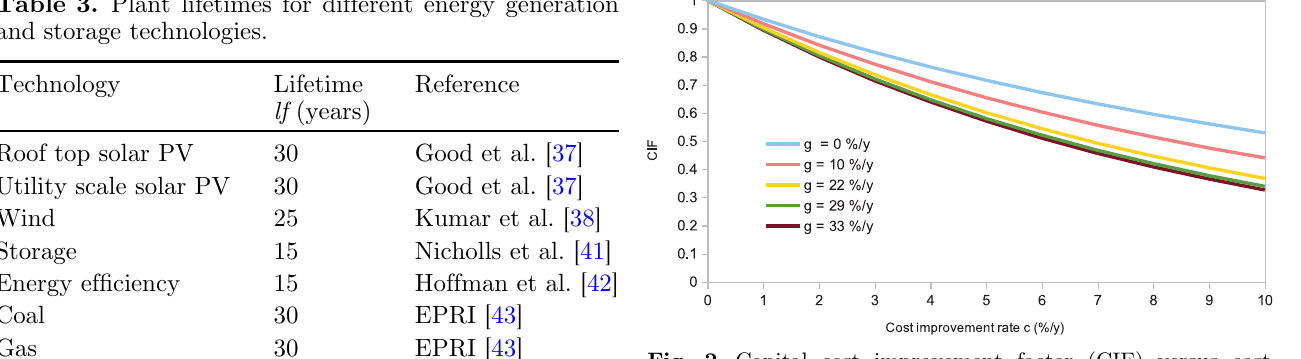
Fig. 2. Capital cost improvement factor (CIF) versus cost improvement rate for different installation growth rates (g). The effect of cost improvement on the overall capital cost of a wind, solar PV or battery system increases with higher installation